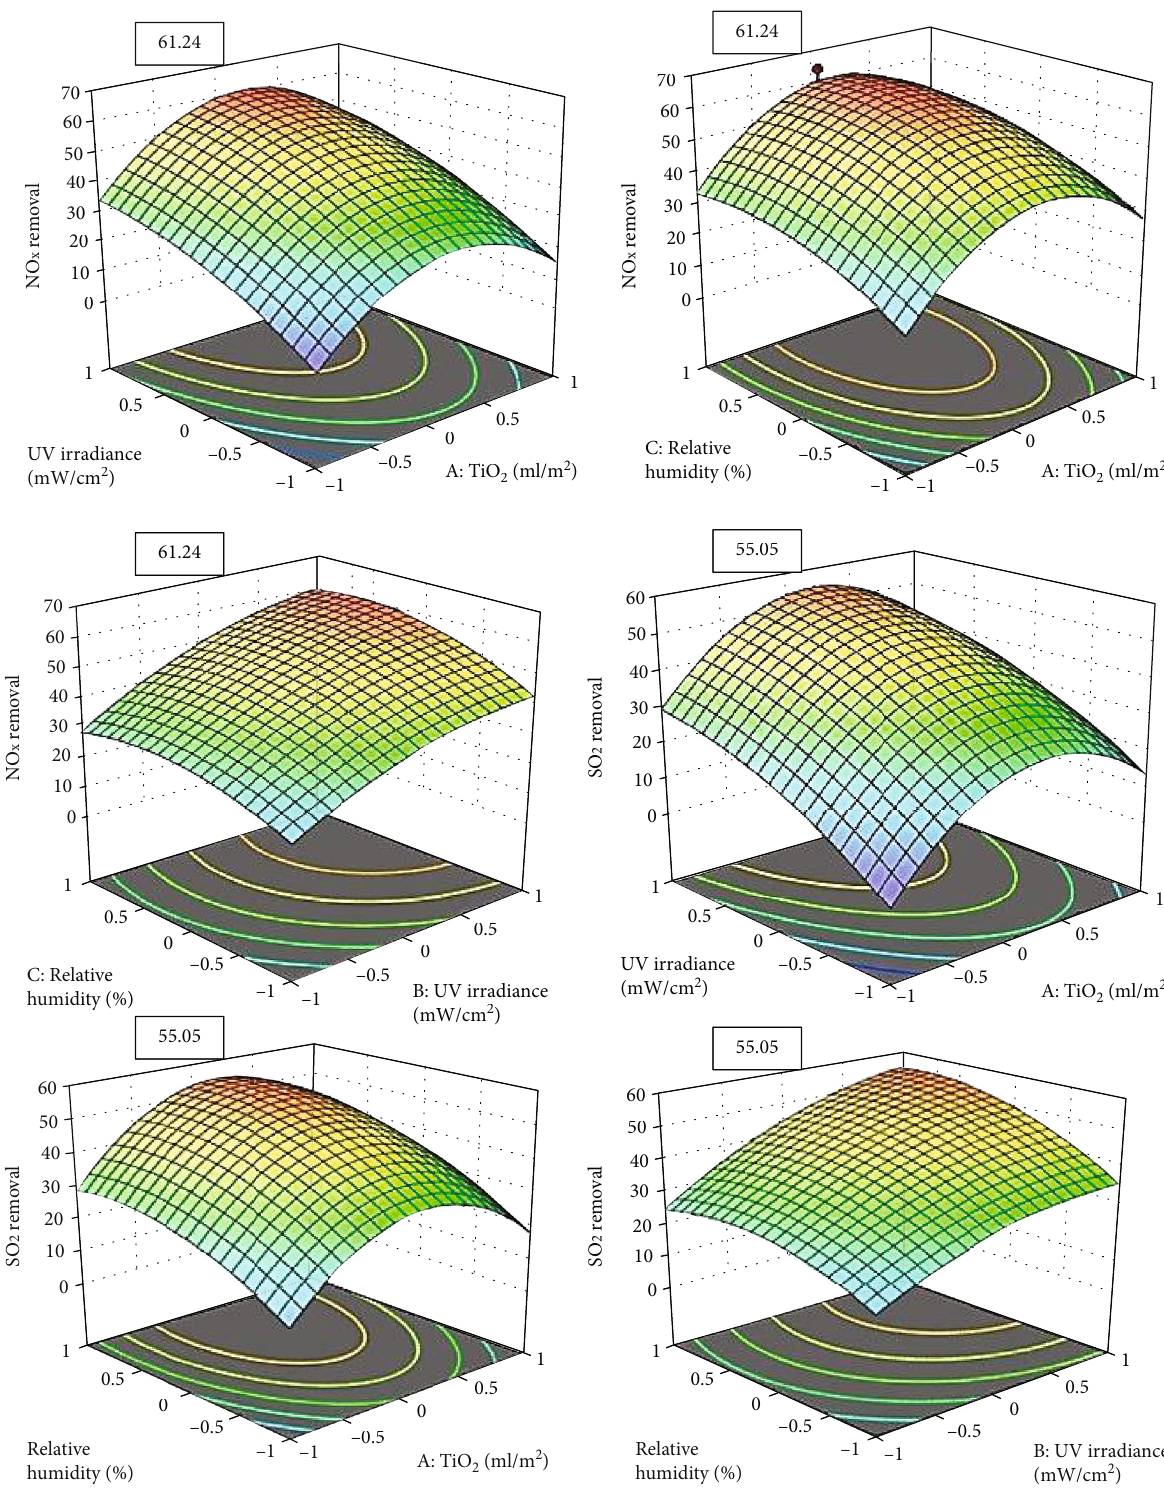
Figure 3: Response surface